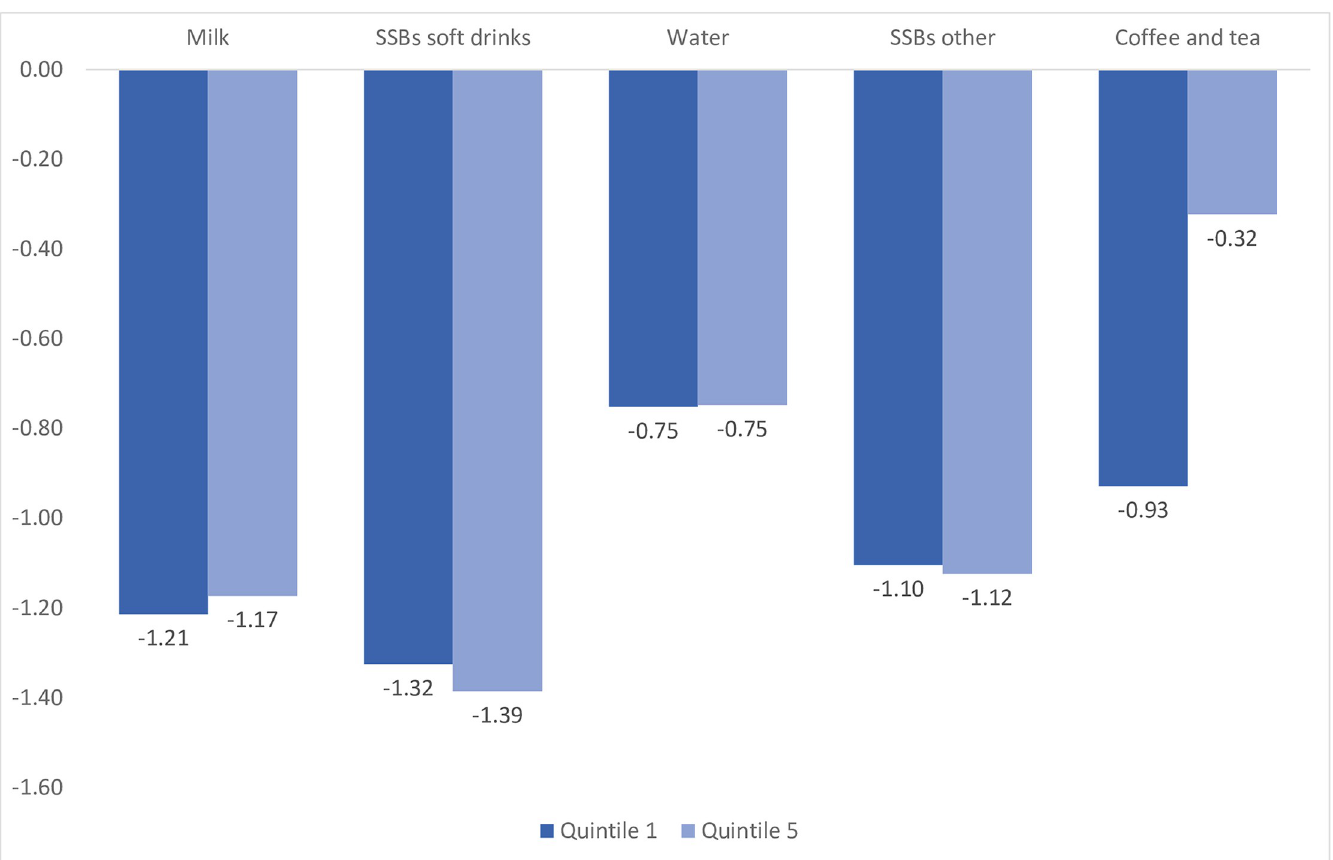
Fig 1. Uncompensated own-price elasticities: High- and low-income consumers. Source: National Survey of Income and Expenditure for Urban and Rural Households 2011–2012. Ecuador.